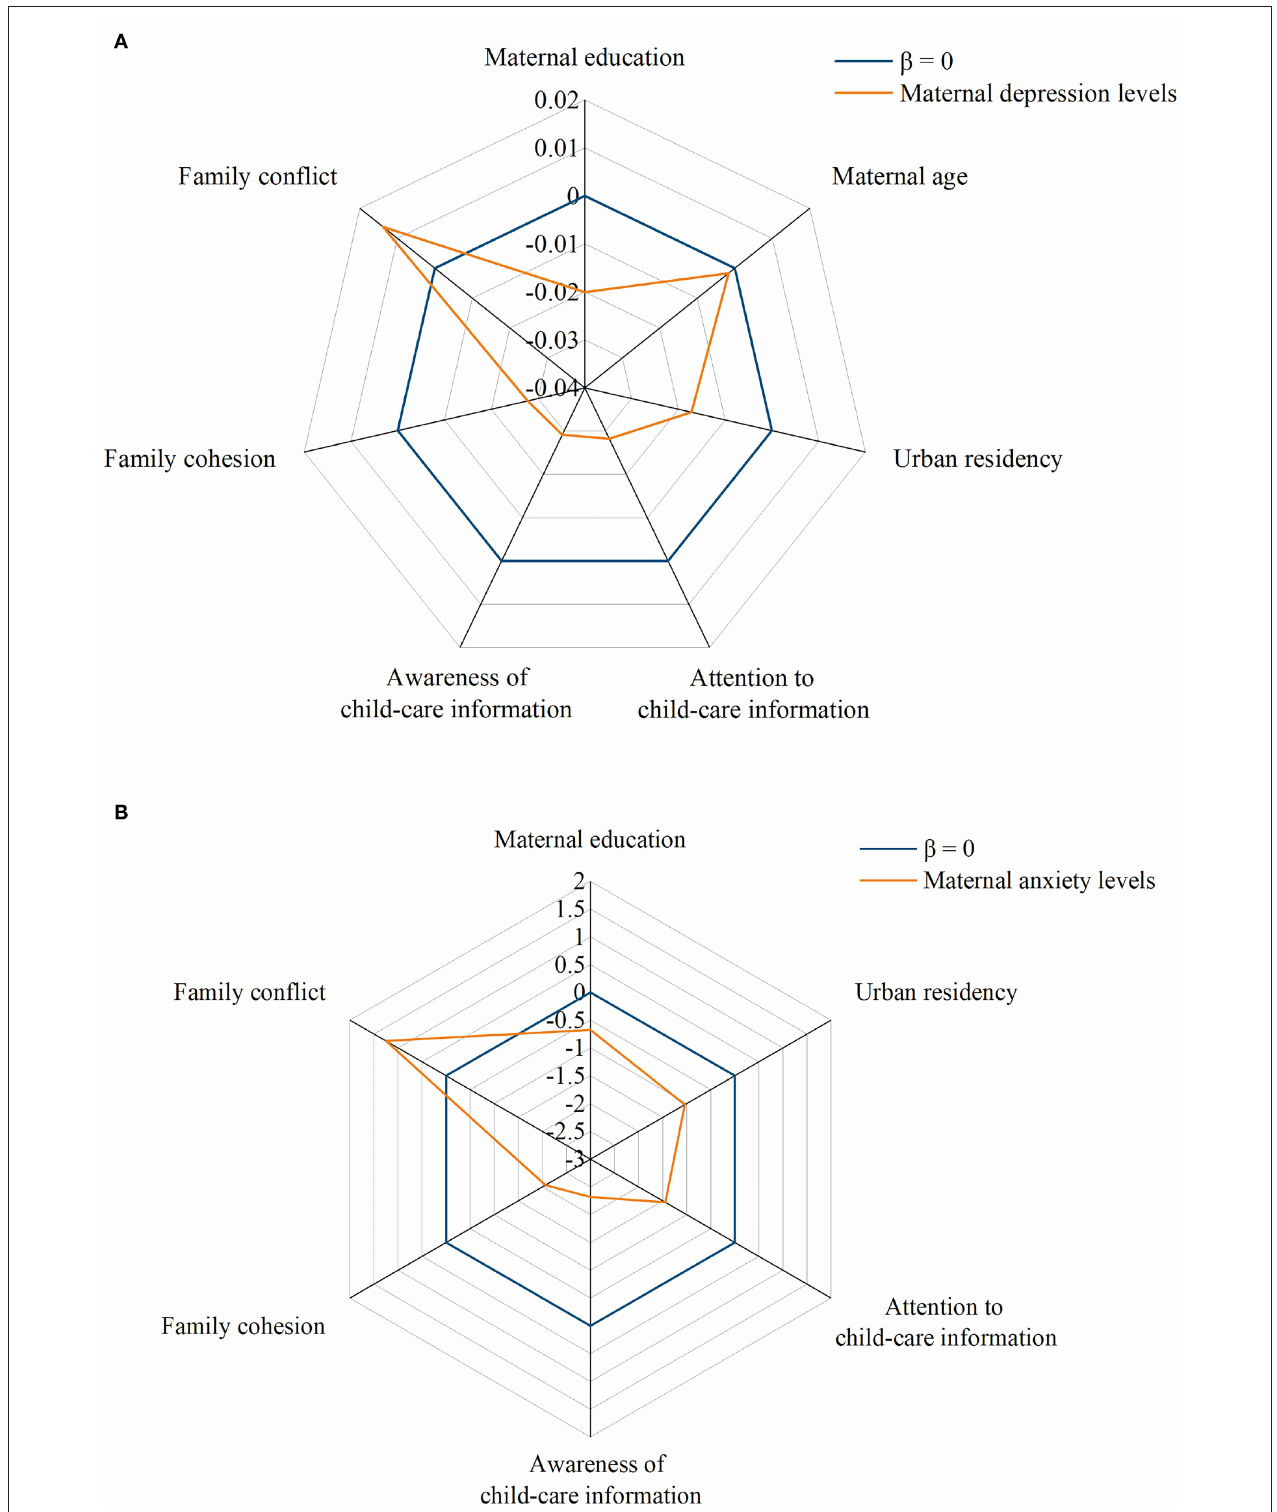
FIGURE 1 | Risk factors for maternal depression and anxiety. Maternal depression (A) and anxiety (B) levels were both negatively associated with maternal education level, maternal age, home urban residence, attention, and awareness to child-care information during the COVID-19 pandemic and family cohesion levels, and positively related to family conflict levels. Maternal depression levels were also negatively associated with maternal age (A)